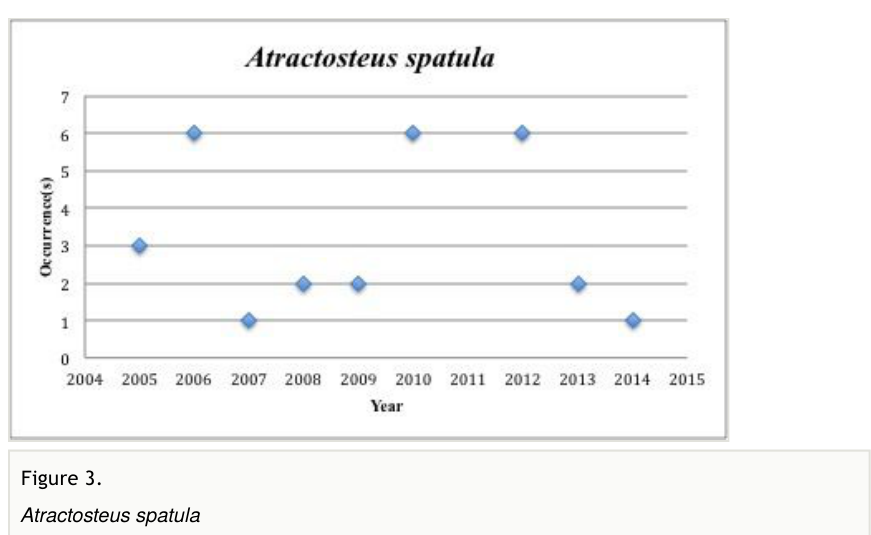
Figure 3. Atractosteus